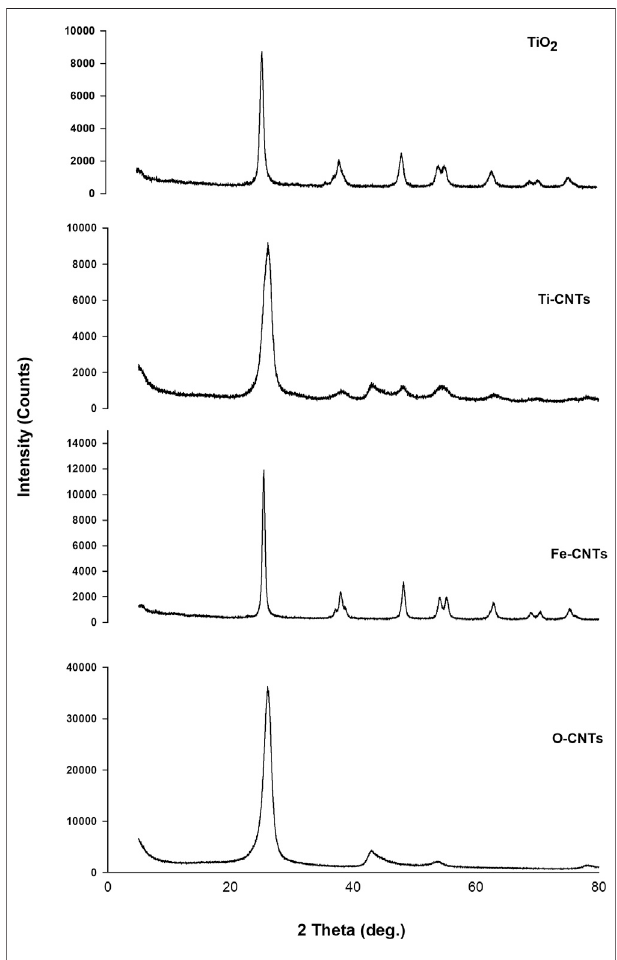
FIGURE 2 | XRD of some main oxides-modi fi ed-CNTs surfaces and O-CNTs.